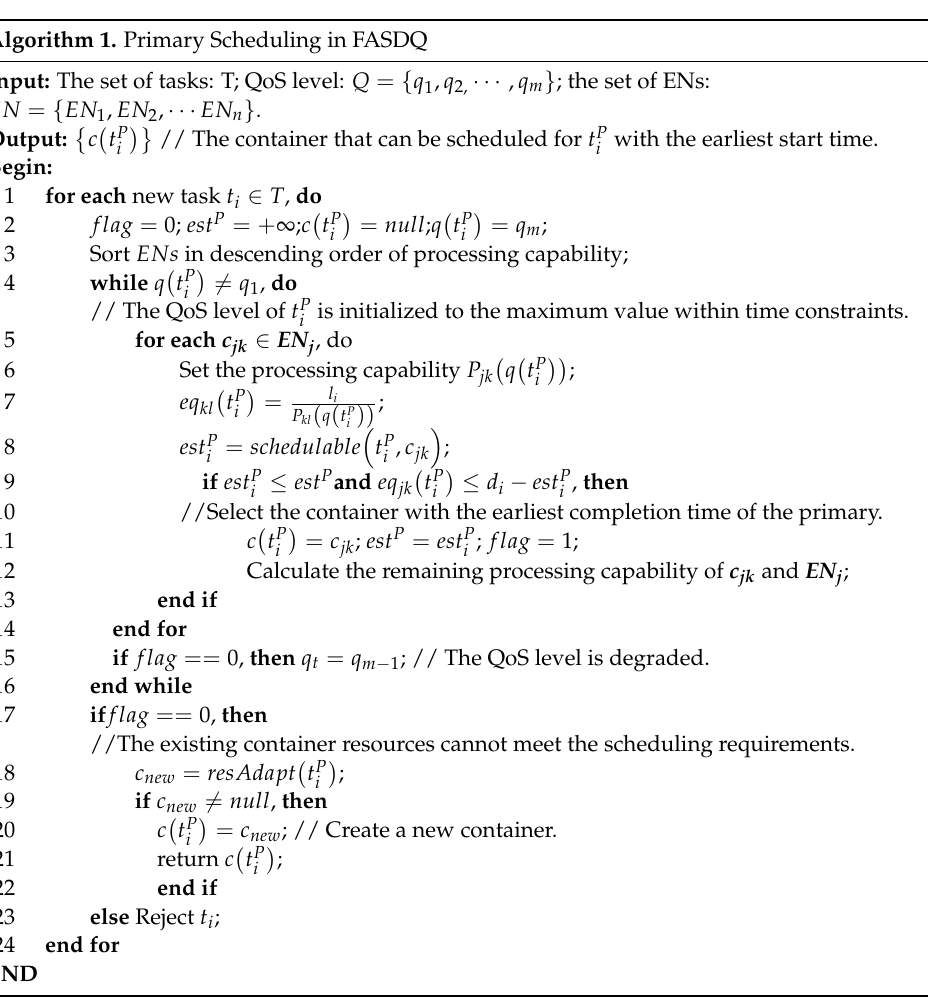
(cid:0) (cid:1) t P Figure 6b: After t p succeeds and t B is released, then schedulable , c 21 determines whether 3 1 1 (cid:2) (cid:3) − σ B t p f P can be scheduled in , s B . If so, the new earliest start time nest P of t P is returned, 2 3 3 1 1 3 (cid:0) (cid:1) (cid:0) (cid:1) t B t B and state is changed. In this example, state is changed from 1 to 0, reducing energy 3 3 (cid:0) (cid:1) t B consumption. Figure 6c: schedulable , c 21 determines whether t B can be scheduled in 2 2 (cid:2) (cid:3) s B , f P , and then the new latest start time nlst p of t B is updated; this can also 2 3 2 3